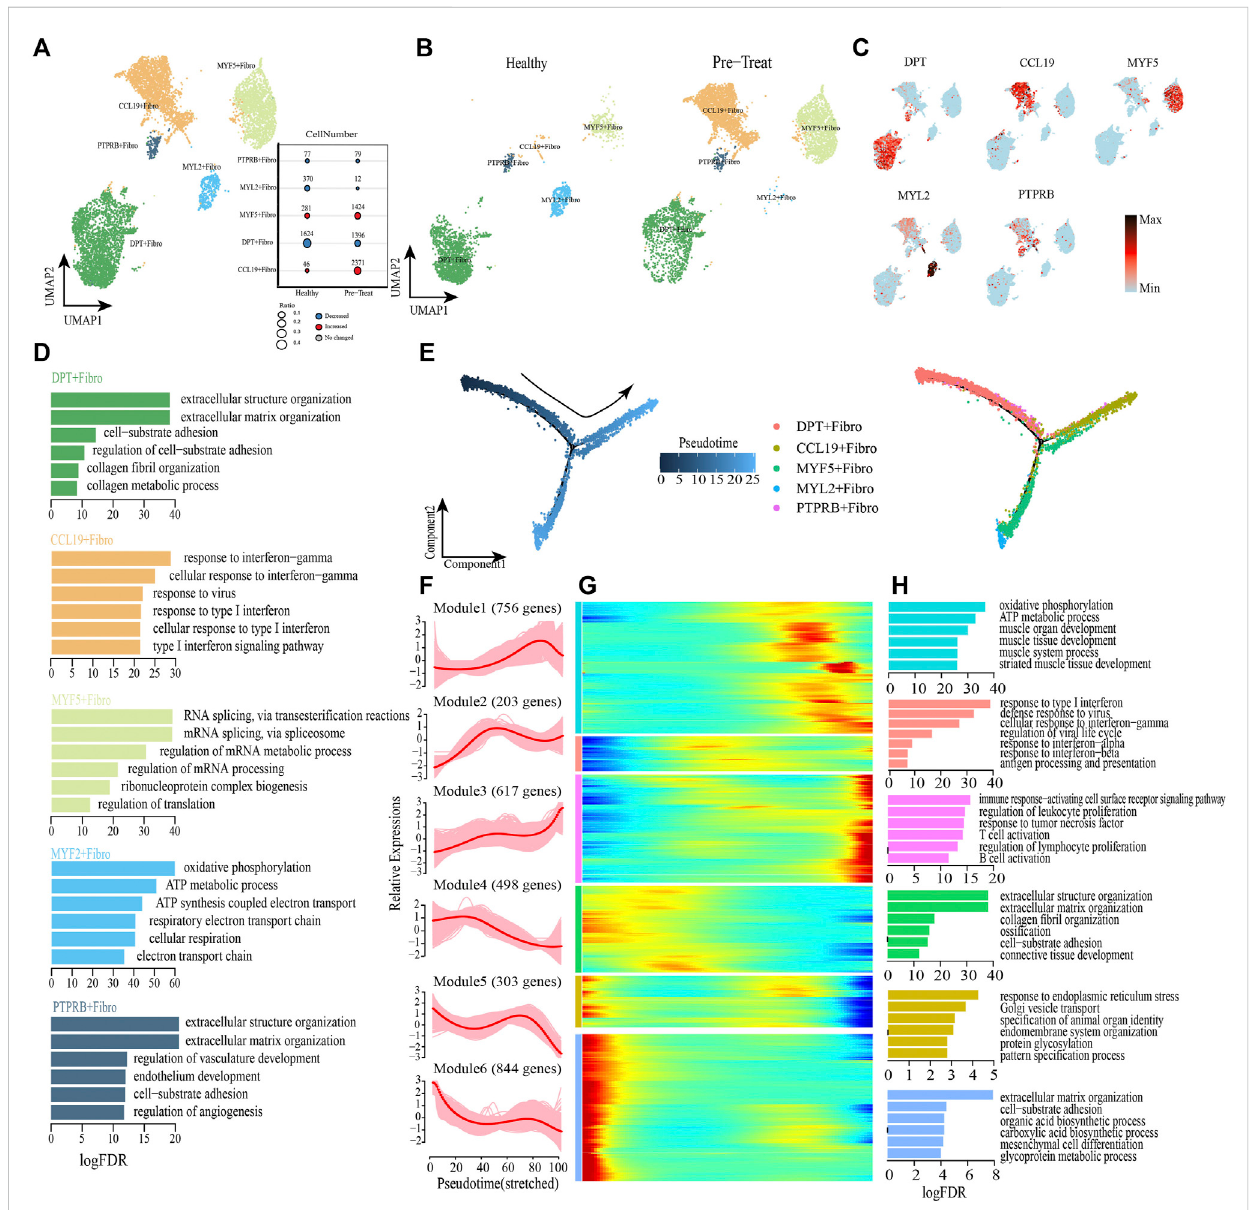
FIGURE 7 Fibroblasts with in fl ammatory gene expression pro fi les emerge in muscle samples of JDM patients. (A,B) Visualization of fi broblast sub-clusters in human muscle sample via Uniform Manifold Approximation and Projection (UMAP) plots by cell identity (A) and different stages (B) . (C) The feature plots of marker genes of fi broblast sub-clusters. (D) GO enrichment analyses of marker genes of fi broblast sub-clusters. (E) Pseudotime trajectory (Monocle analysis)ofthe fi broblast.Cellsarecoloredbasedaccordingtothepredictedpseudotime(left)andgroups(right). (F) Theexpressiondynamicsoftop DEGs were cataloged into six major clusters in a pseudotime manner. (G) Gene expression heatmap of top DEGs (cataloged in six clusters) in a pseudo- temporal order. (H) GO enrichment analyses of each gene